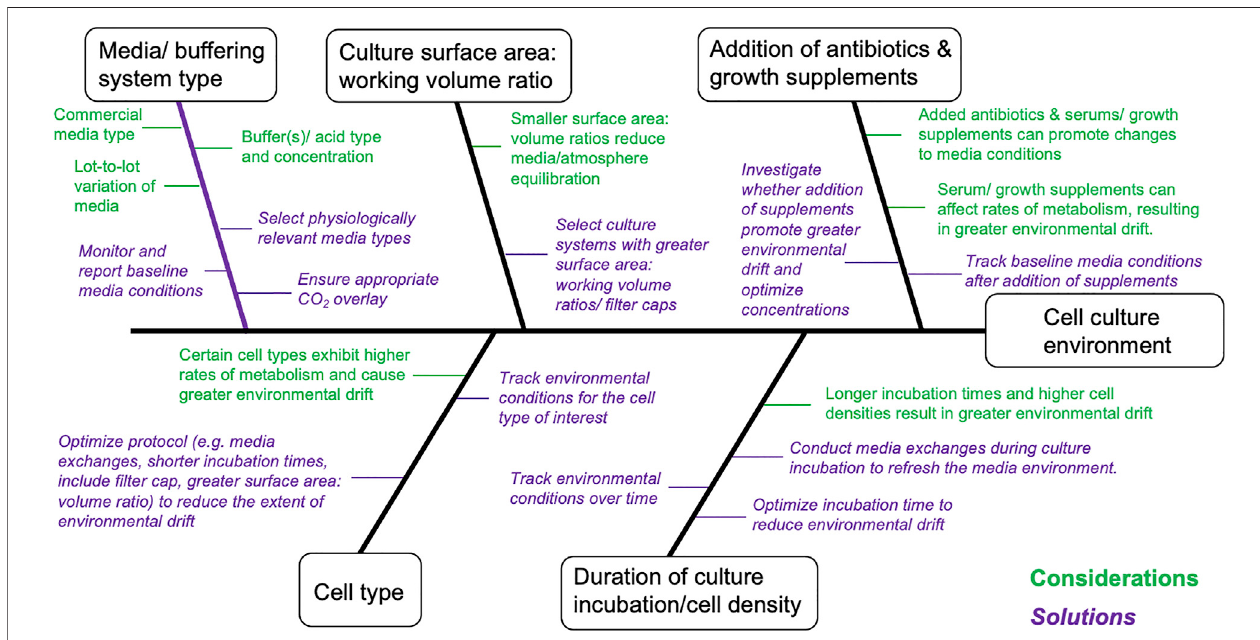
considerations affecting in vitro cell cultures and statements marked in Purple (italicized) are proposed